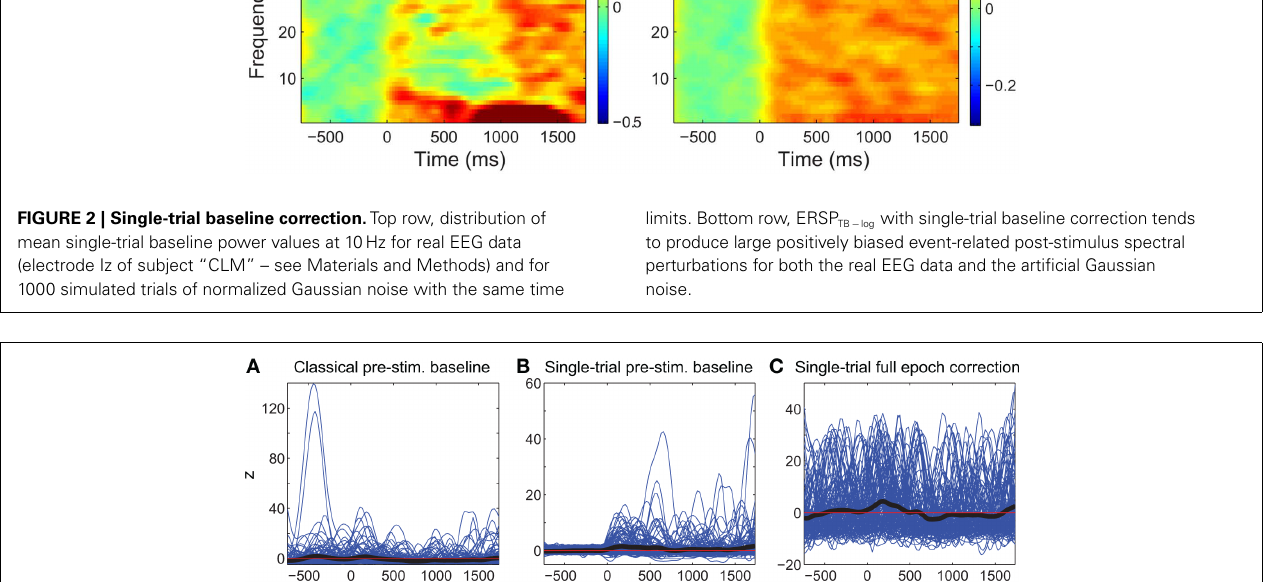
FIGURE 3 | Comparison of different baseline approaches. This figure shows spectral power at 5.8Hz in single-trials using the classical pre-stimulus baseline ERSP